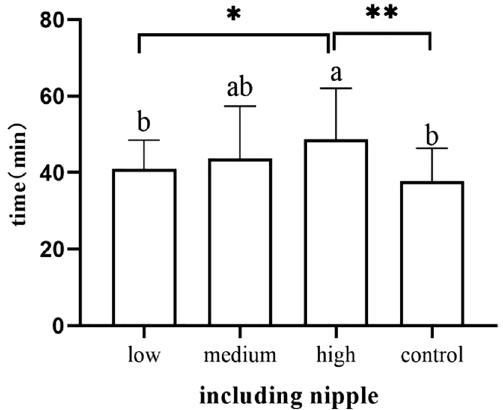
Figure 9. Occurrence time of including nipple.